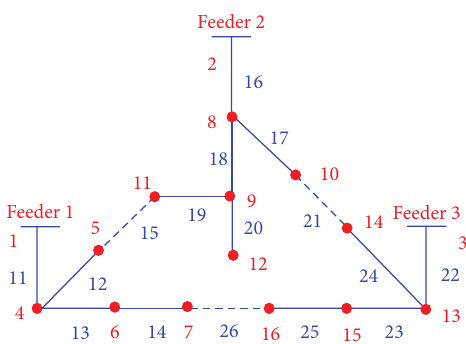
Algorithm 2 (SPEA2) and Nondominated Sorting Genetic